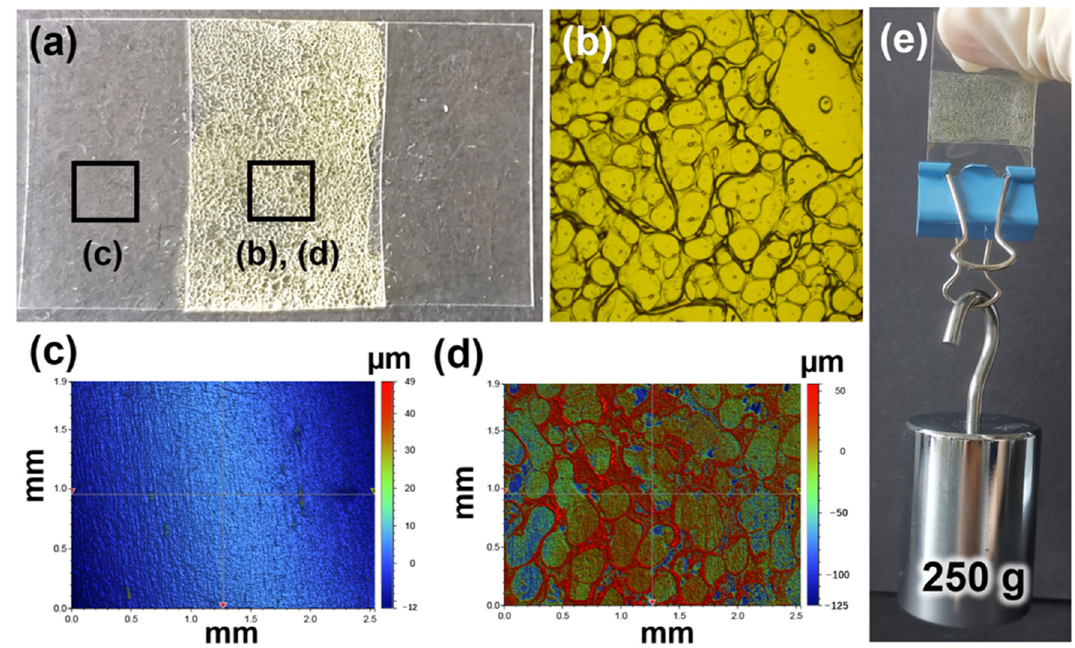
Figure 6. ( a ) Photographic image of the PP plates adhered by crosslinked GAP; ( b ) Optical micro- scopic image of the adhered region; Optical profile topography images of ( c ) unadhered region and ( d ) adhesion region; ( e ) Photographic image of the 250 g weight lifted by two adhered PP plates.